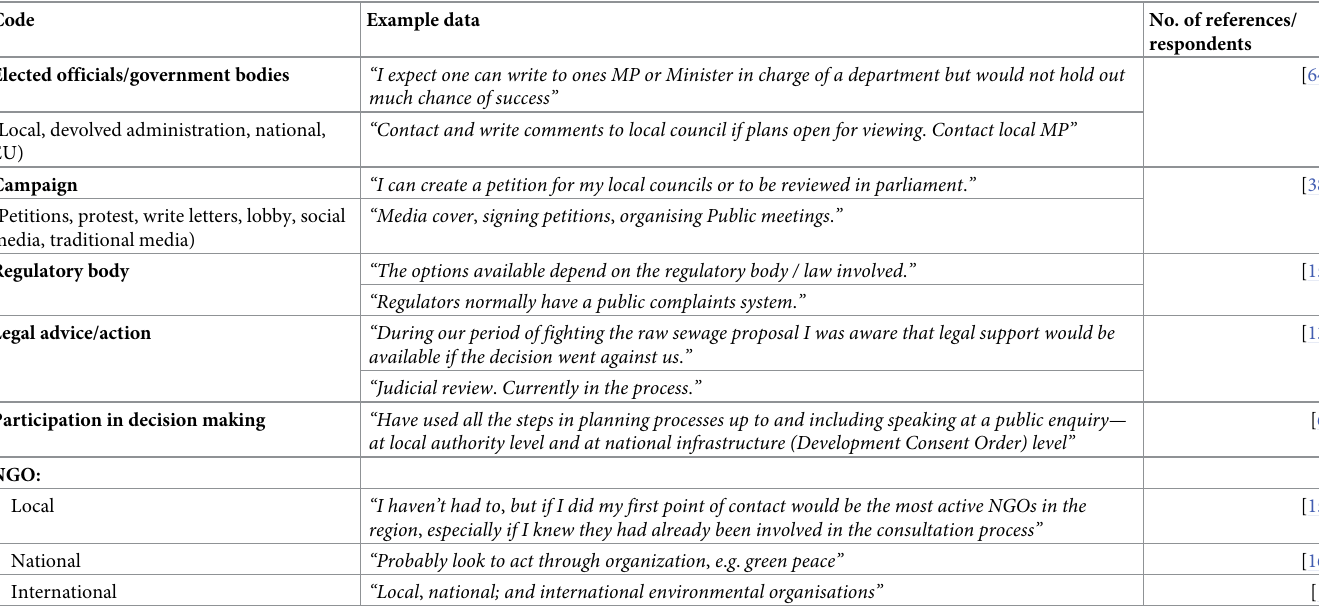
Table 9. Awareness of environmental justice. Means of seeking environmental redress proposed by a sample of active marine citizens. (n =